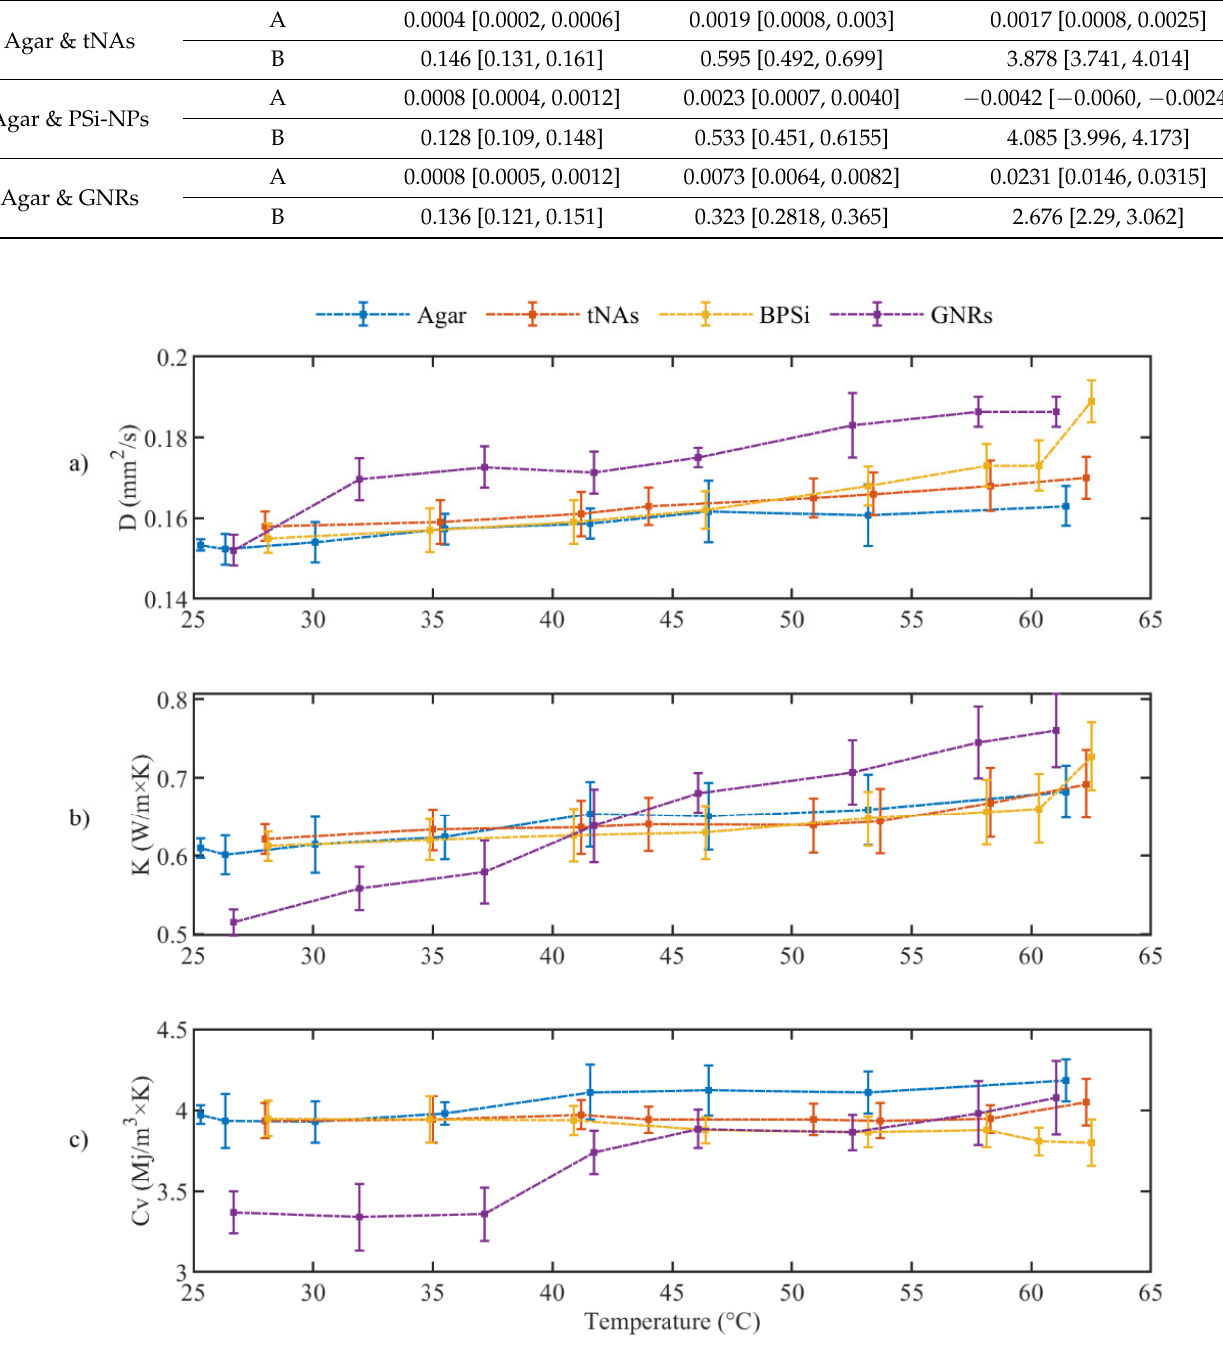
Figure 6. ( a ) Fitting curve for ( a ) thermal diffusivity, ( b ) thermal conductivity and ( c ) volumetric heat capacity, for agar with and without NPs.